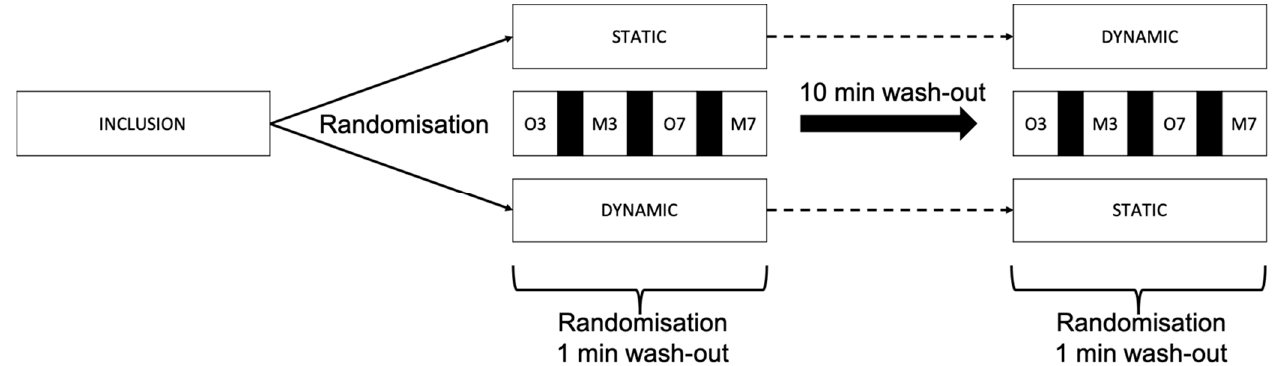
Figure 1. Study flow diagram.